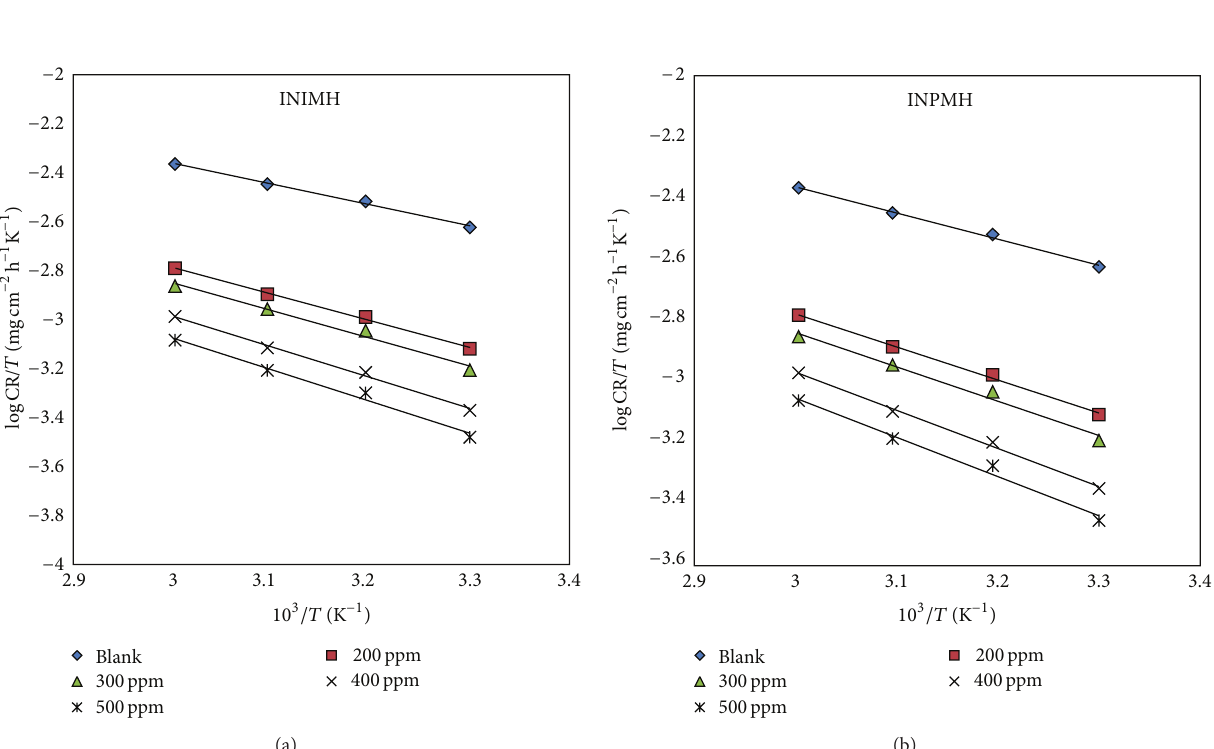
Figure 3: Alternative Arrhenius plots for MS dissolution in 0.5 MHCl medium in the absence and presence of INIMH and INPMH.